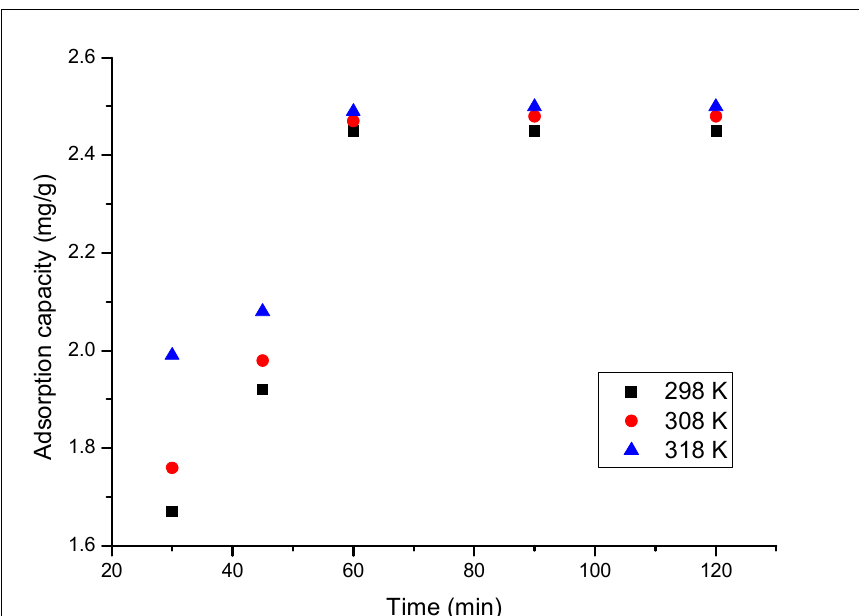
Figure 9. The contact time and temperature in fl uence.